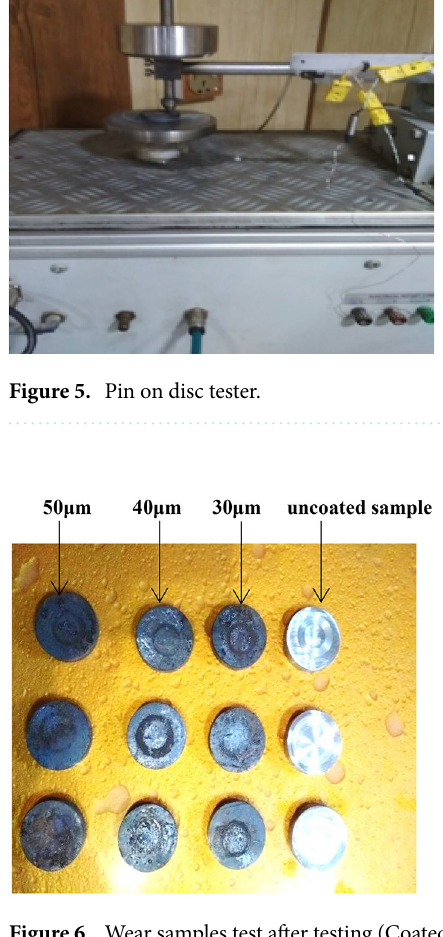
Figure 6. Wear samples test after testing (Coated and